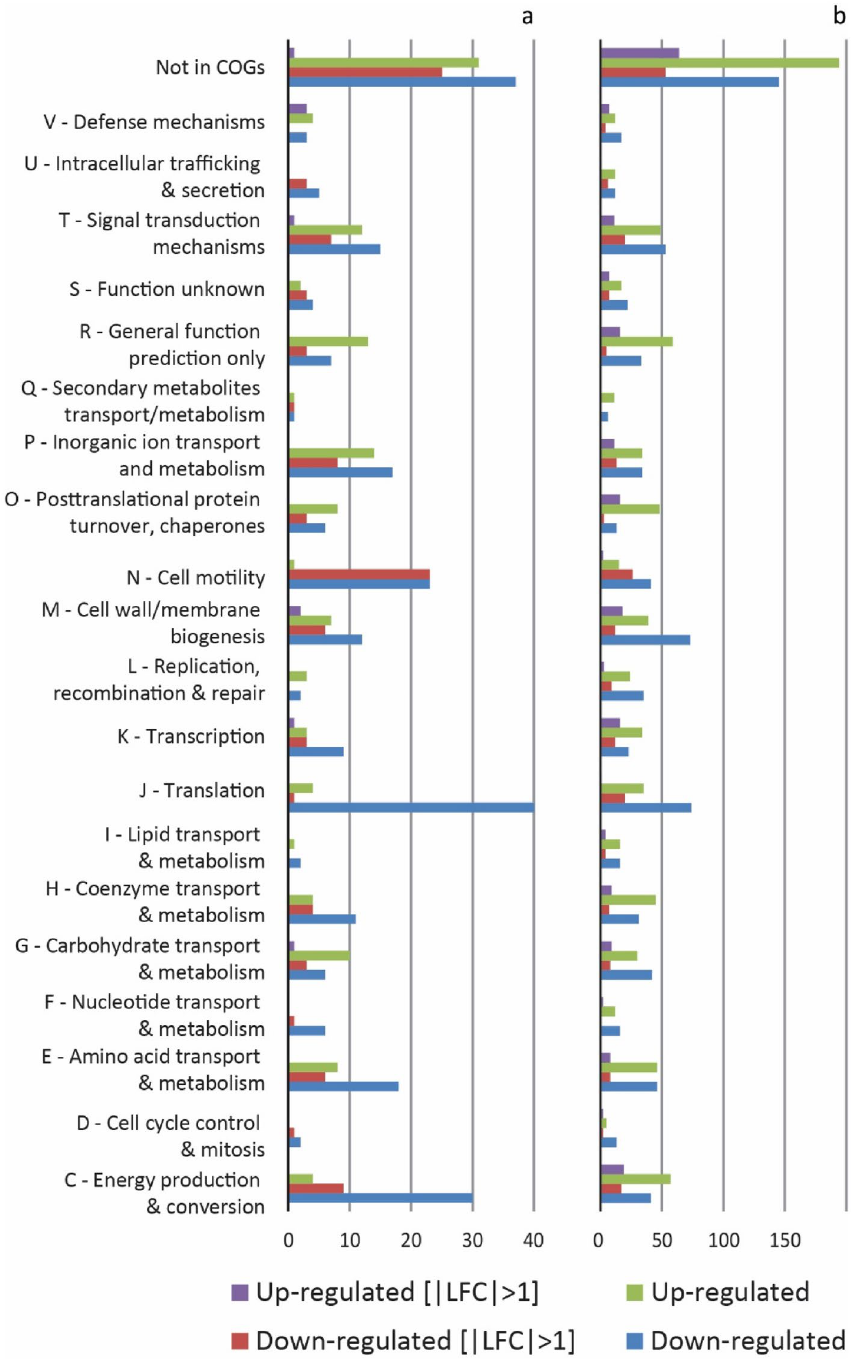
Figure 8. Clusters of orthologous groups (COGs) analysis of transcriptional changes in cells of L. ferriphilum DSM 14647 T after exposure to DSF/BDSF ( a ) and AHLs (b). Numbers COG-assigned differentially expressed genes with p adj < 0.005 are shown as green and blue bars for higher and fewer RNA transcripts, respectively (393 and 1450 genes in total for DSF/BDSF and AHLs, respectively). Purple and red bars indicate the fraction of RNA transcripts with |LFC|> 1 (100 and 419 genes for DSF/BDSF and AHLs,